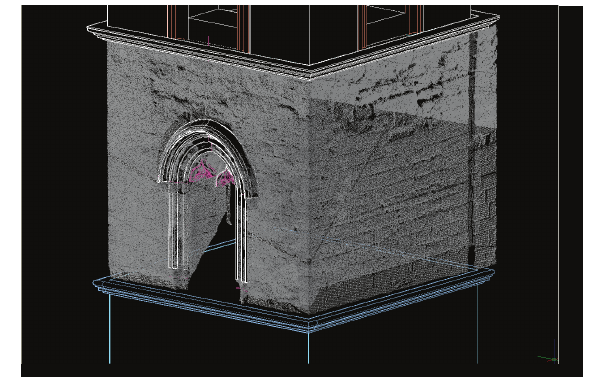
Figure 17. From the cloud point to the geometric model of Saint Thomas’s belfry second